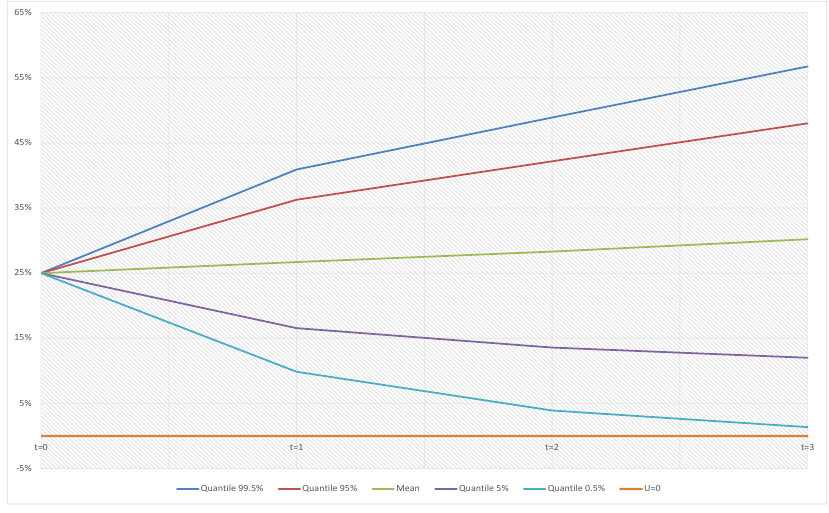
Figure 13. ˜ u t , for t = 0, 1, 2, and 3 net of Excess of Loss (XL) Reinsurance-Baseline portfolio mix ( u 0 =